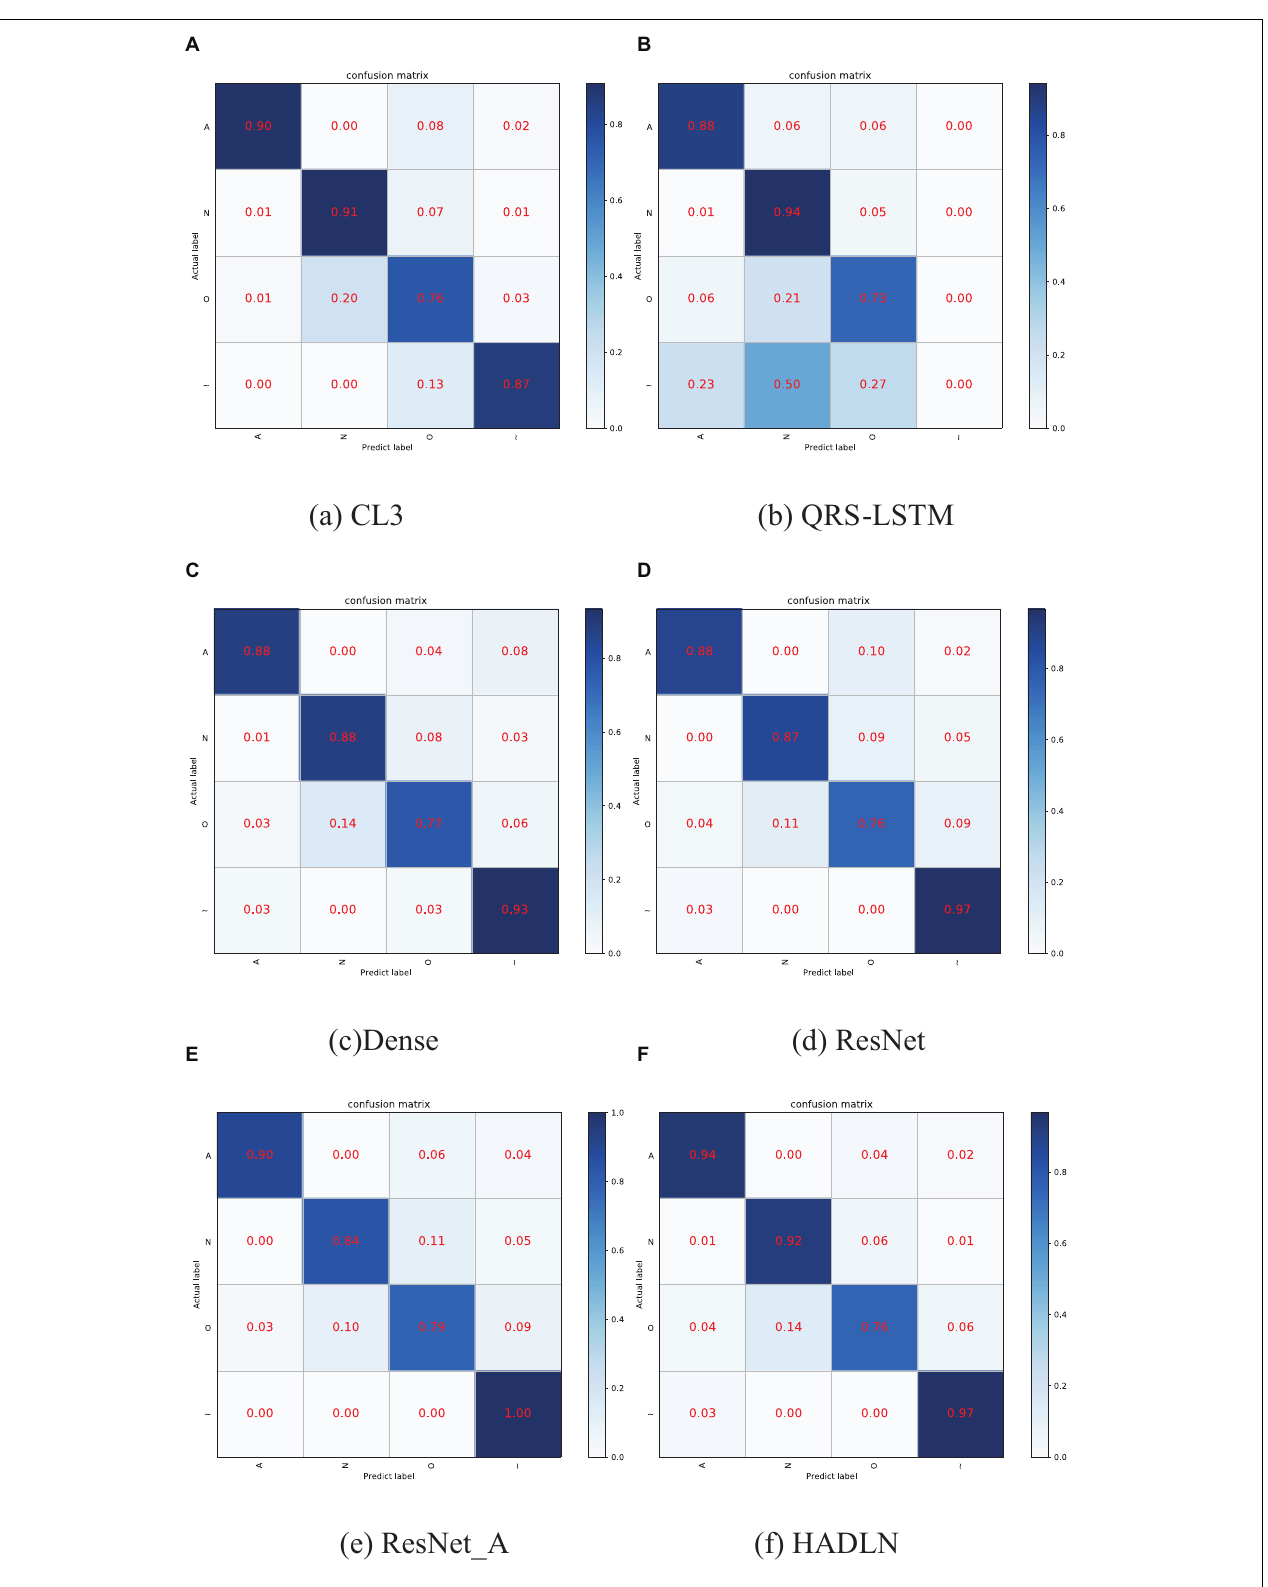
FIGURE 6 | Confusion matrices by using different classification methods. (A) CL3 method, (B) QRS-LSTM method, (C) Dense method, (D) ResNet method, (E) ResNet_A method, and (F) HADLN method. The percentage of all records in each category is displayed on a color gradient scale.